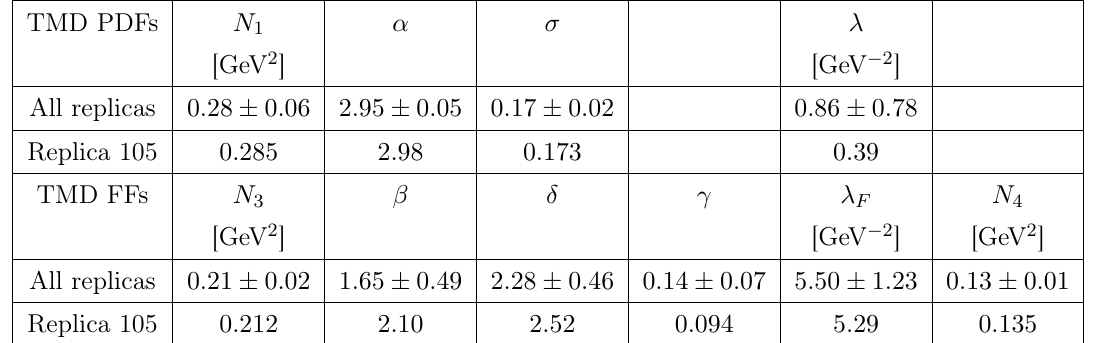
Table 11 . 68% confidence intervals of best-fit values for parametrizations of TMDs at Q = 1 GeV.